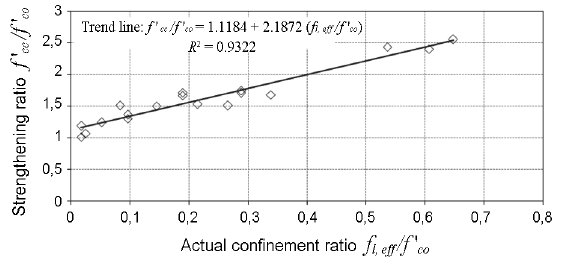
Fig. 12. Strengthening ratio vs. actual confinement ratio